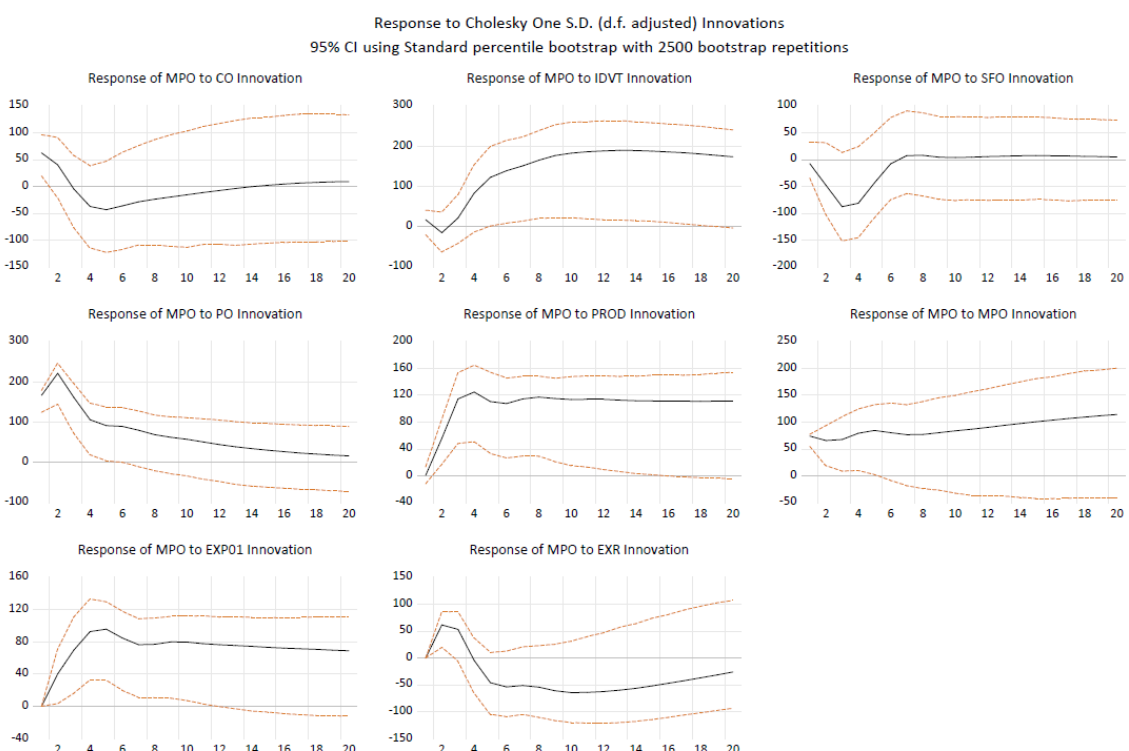
Figure 7. Impulse response after replacing SBO with SFO.